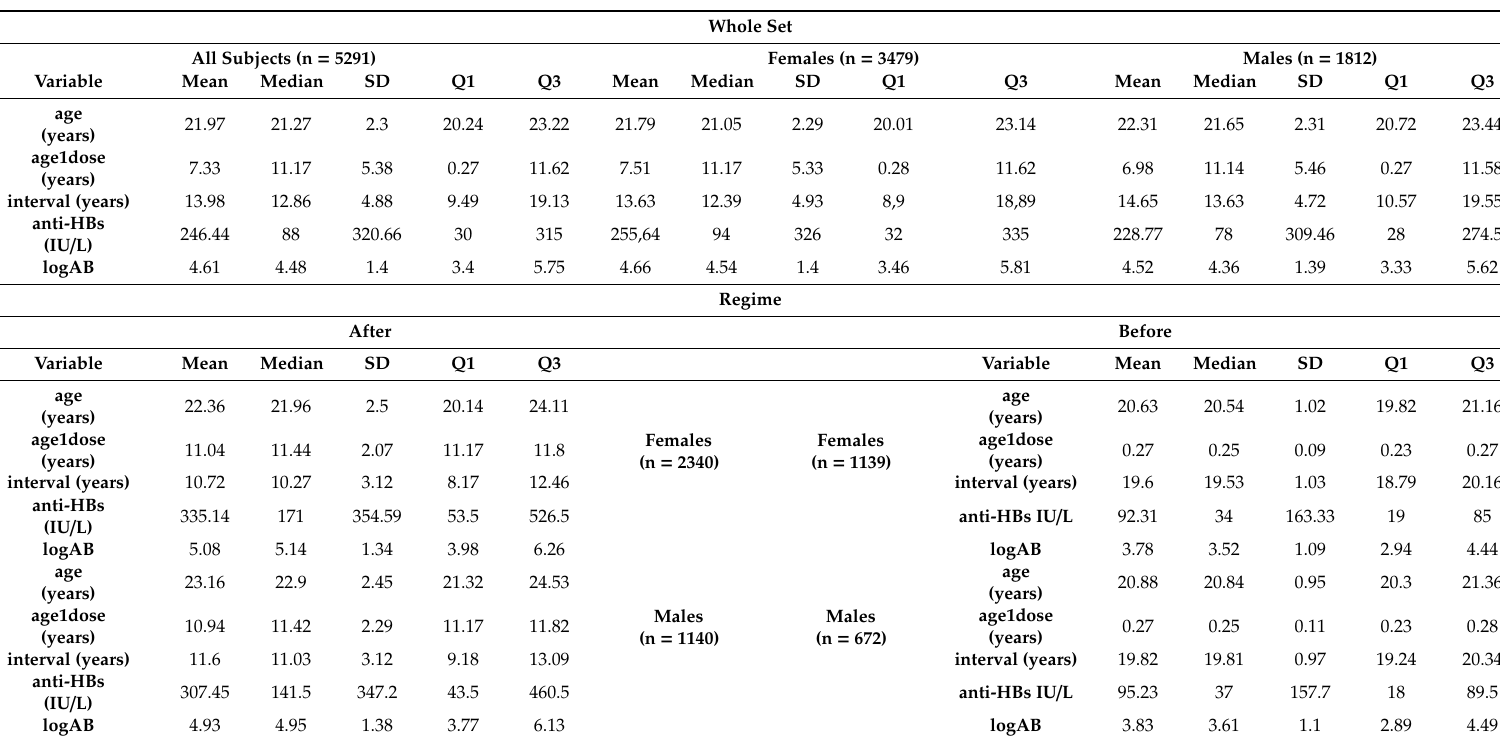
Table 1. Descriptive statistics of the whole data set either aggregated and subdivided by gender (upper part of the table) and the descriptive statistics distinguished by regime (BEFORE / AFTER corresponds to the threshold of one year of age at vaccination) (bottom part of the table). It is important to note how this binary classification of regime stems directly from the data set, being the first and third quartile (Q1, Q3) of age at first dose equal to 0.23–0.27 and 11.17–11.82 for BEFORE and AFTER classes (females, males have very similar values), respectively, thus pointing to the existence of two separated classes of infant and adolescent age vaccination